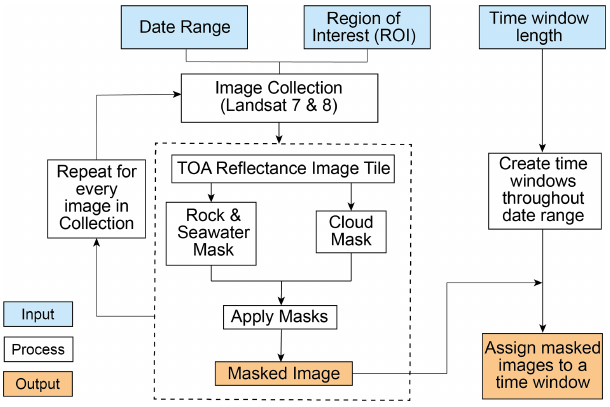
Figure 2. Flowchart illustrating the optical image masking steps taken within GEE, including the method by which images are as- signed to time windows. See Fig. S1 in the Supplement for the threshold values (Moussavi et al., 2020) used during each masking